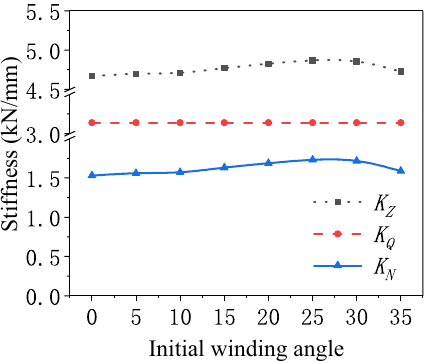
Figure 8. Schematic diagram of the stiffness of the air spring varying with the initial winding angle.